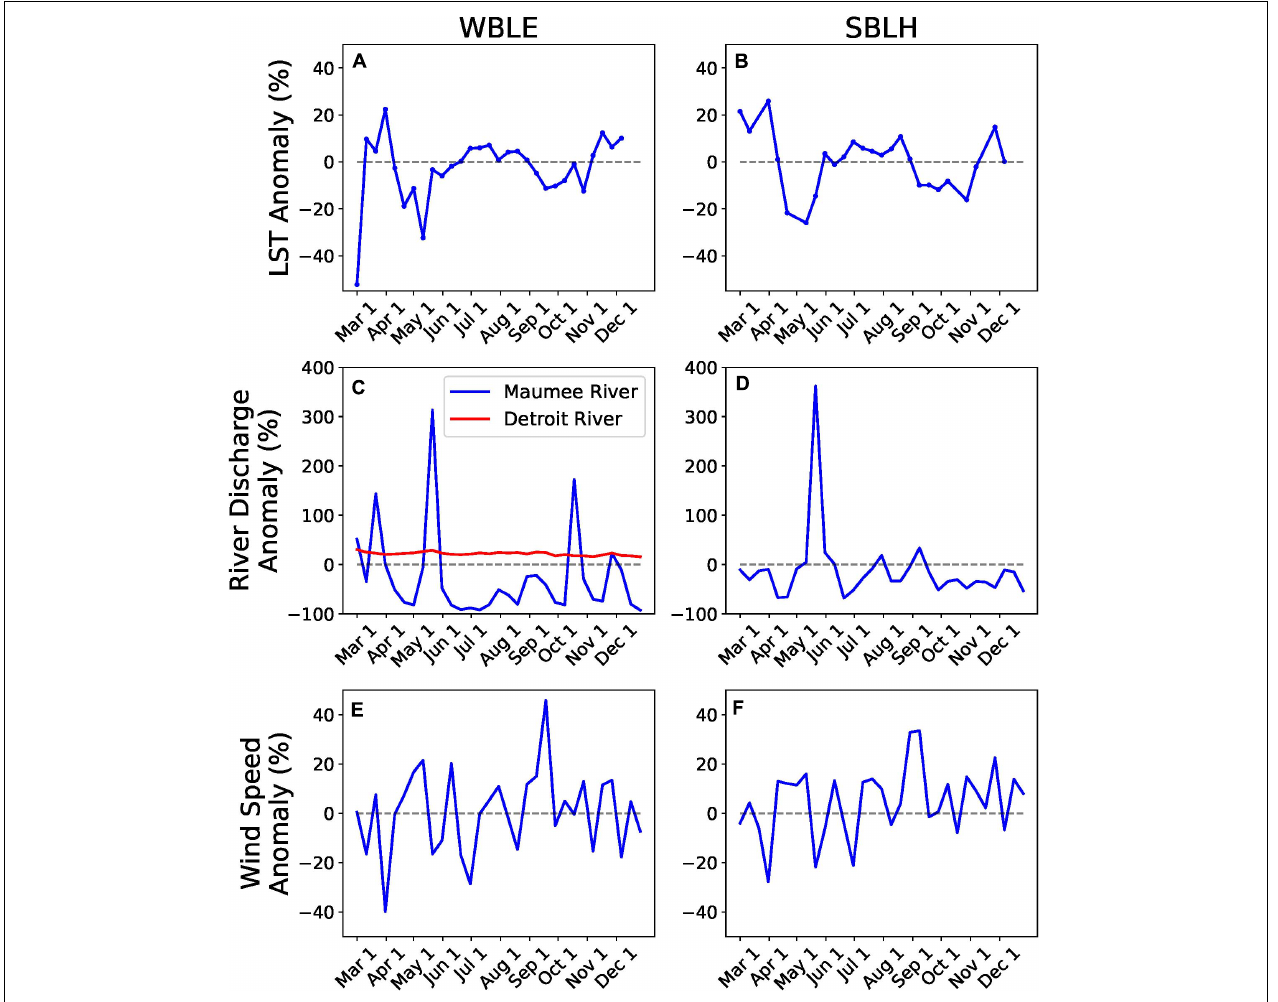
FIGURE 8 | Median 10-day anomalies for the explanatory indicators, including lake surface temperature (A,B) , river discharge (C,D) , and wind speed (E,F)